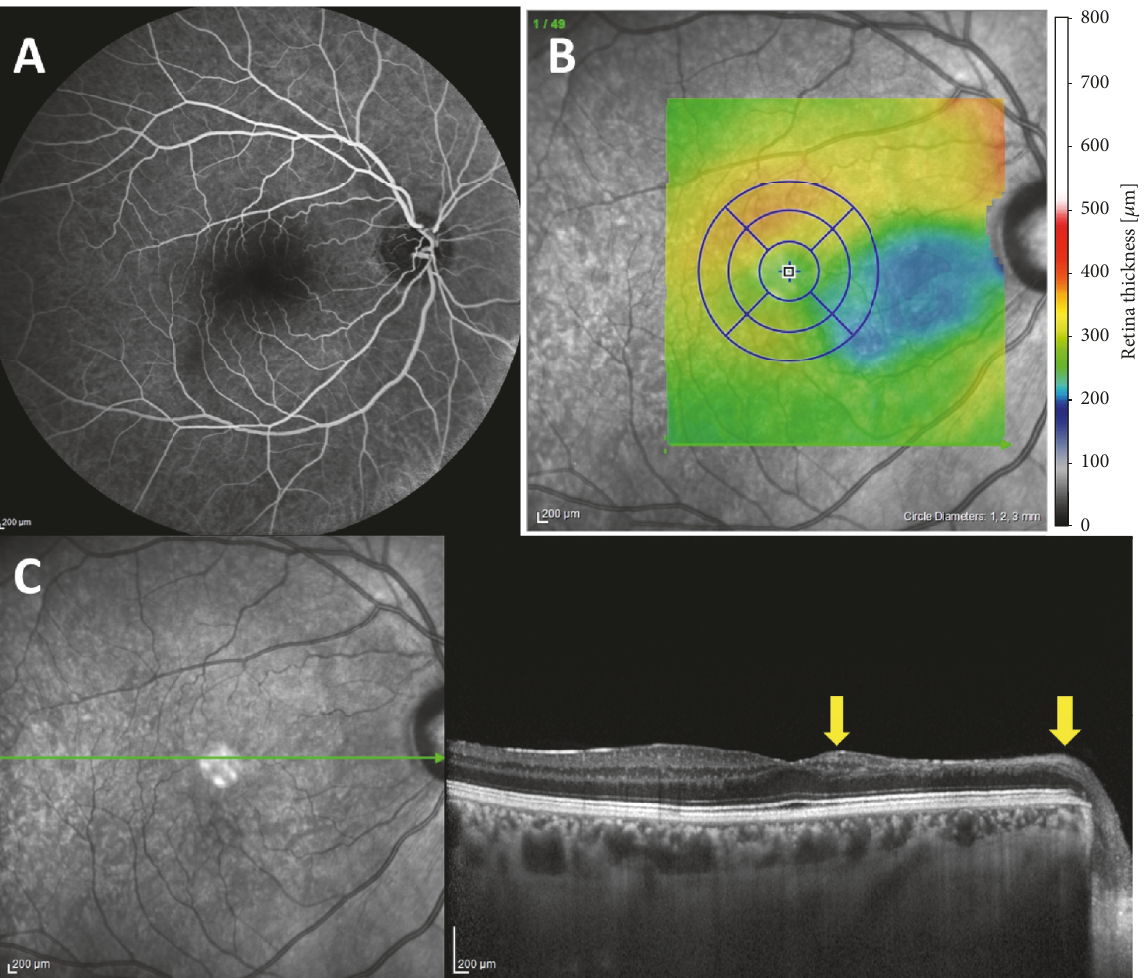
Figure3:Atfollow-up,earlyphaseofFAshowingquitenormalfillingofthecilioretinalarterysparing(A).Theretinalcapillarynetworkiswell perfused on this magnification of the posterior pole. Spectral-domain OCT density map delineating areas of atrophy (blue) corresponding to cilioretinal arteriole occlusions (B). Spectral-domain OCT delineating areas of atrophy (arrows) corresponding to distribution of cilioretinal artery occlusion